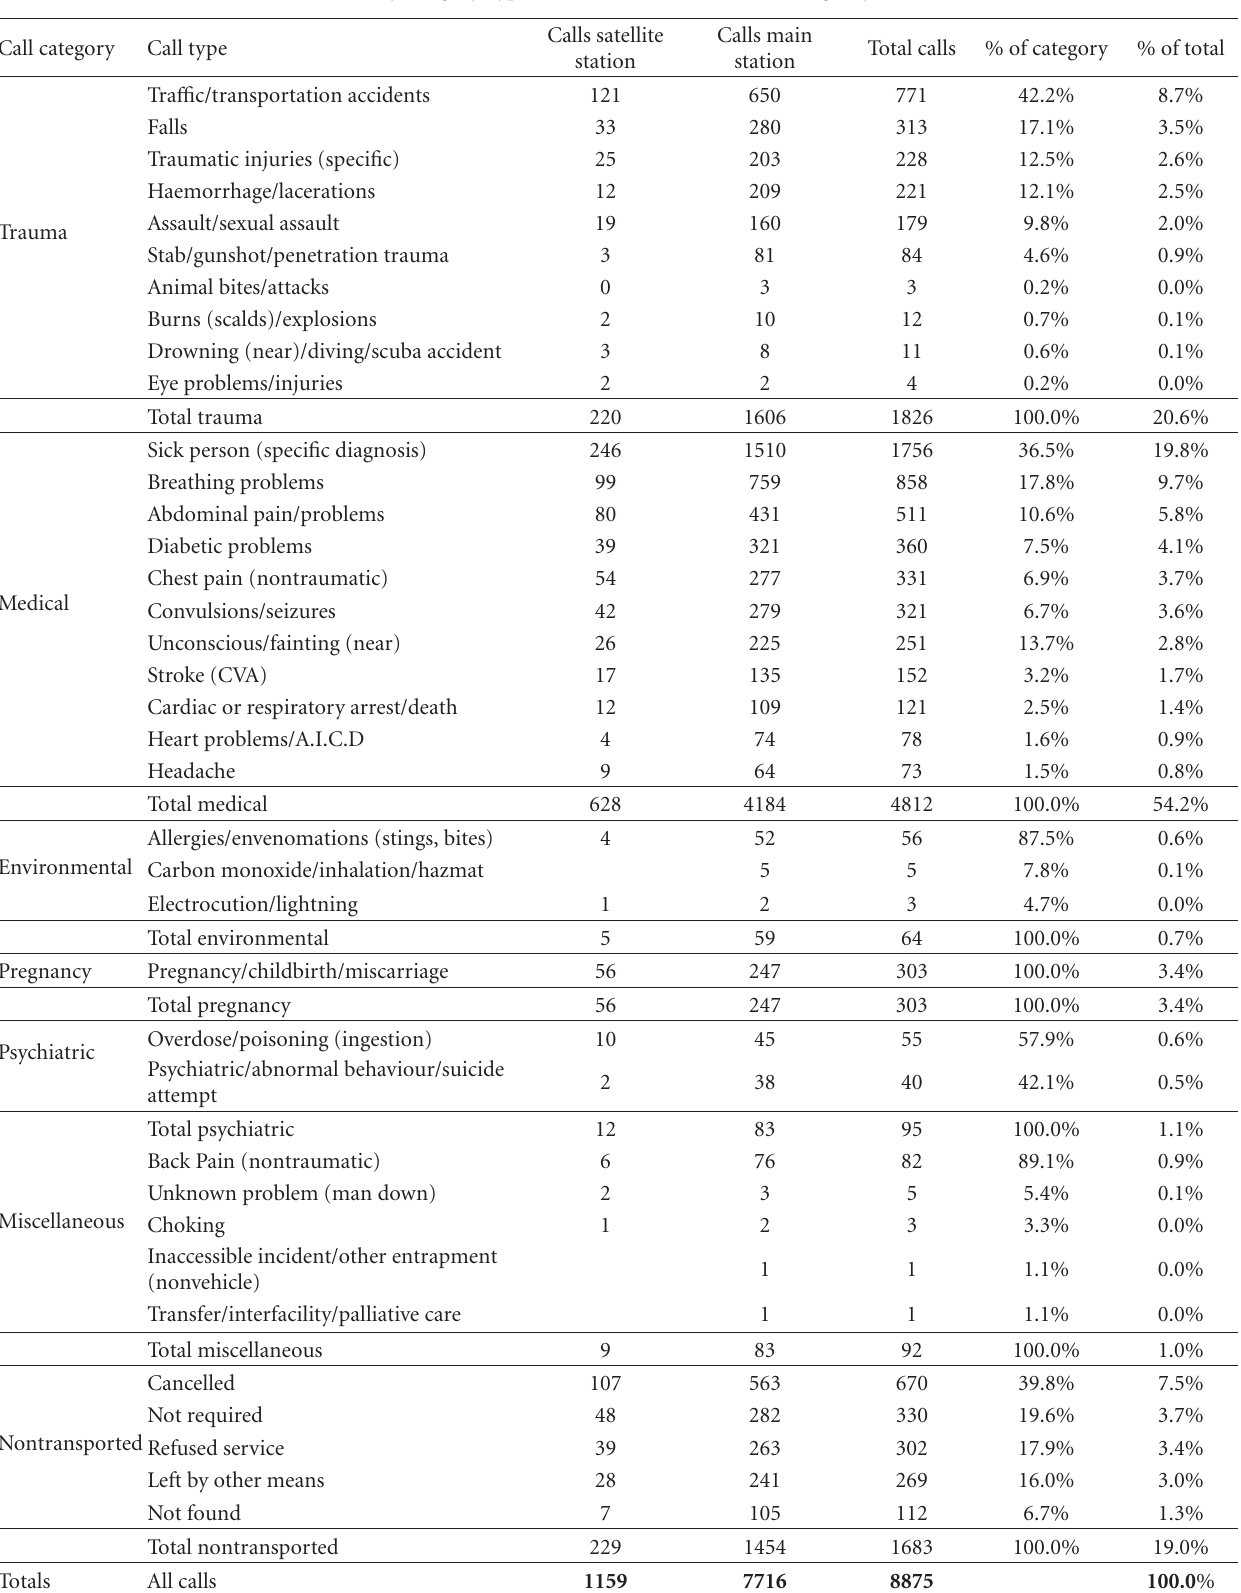
Table 1: Distribution of calls by category, type, and station; the Barbados Emergency Ambulance Service (2005). Call